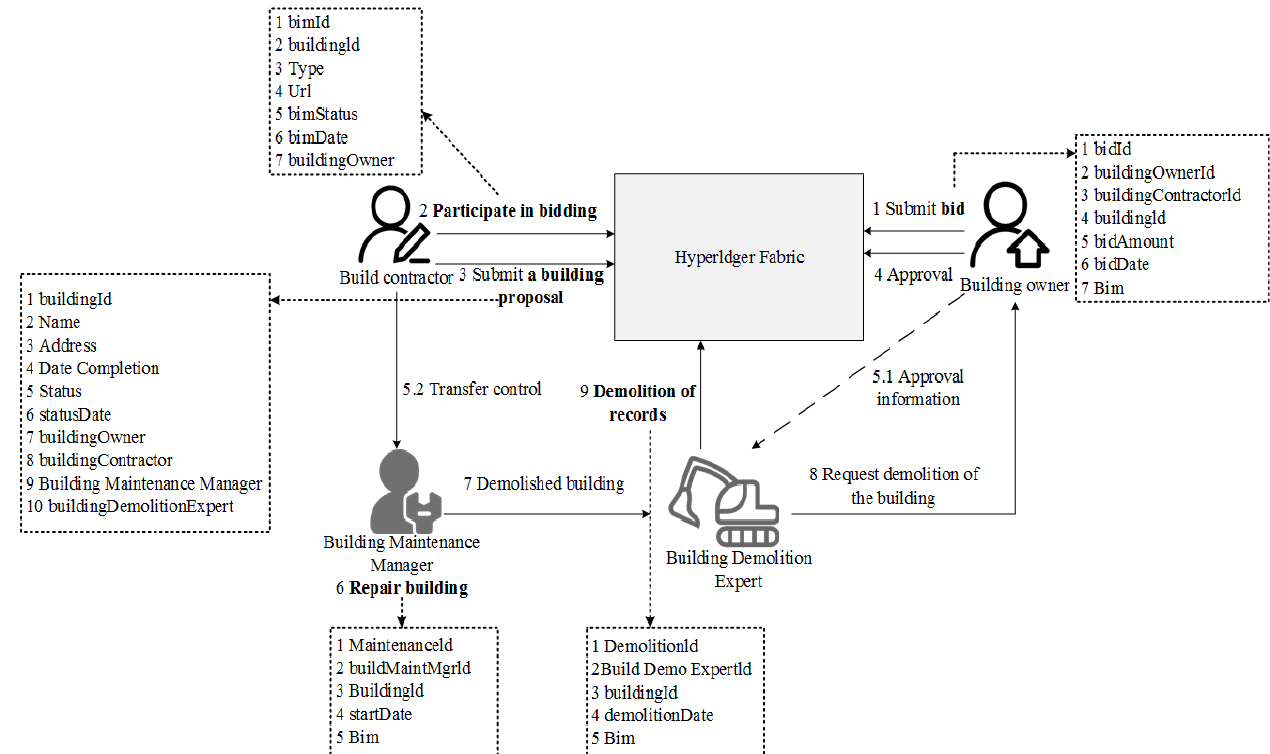
Figure 44. Reconstruction diagram of reference [78].